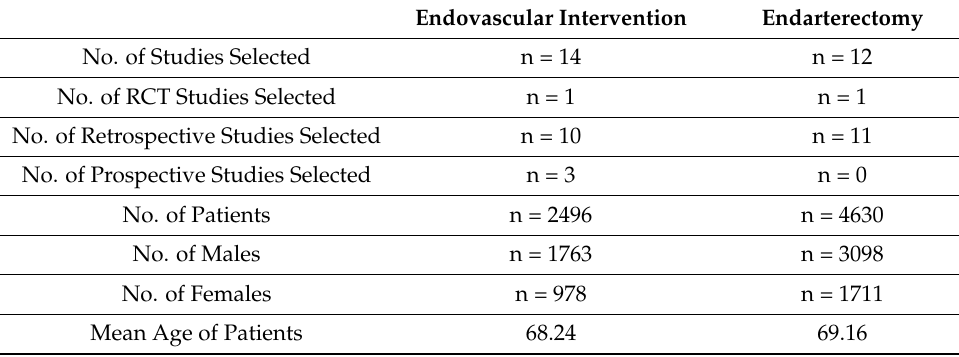
Table 1. Summary of studies included and patient